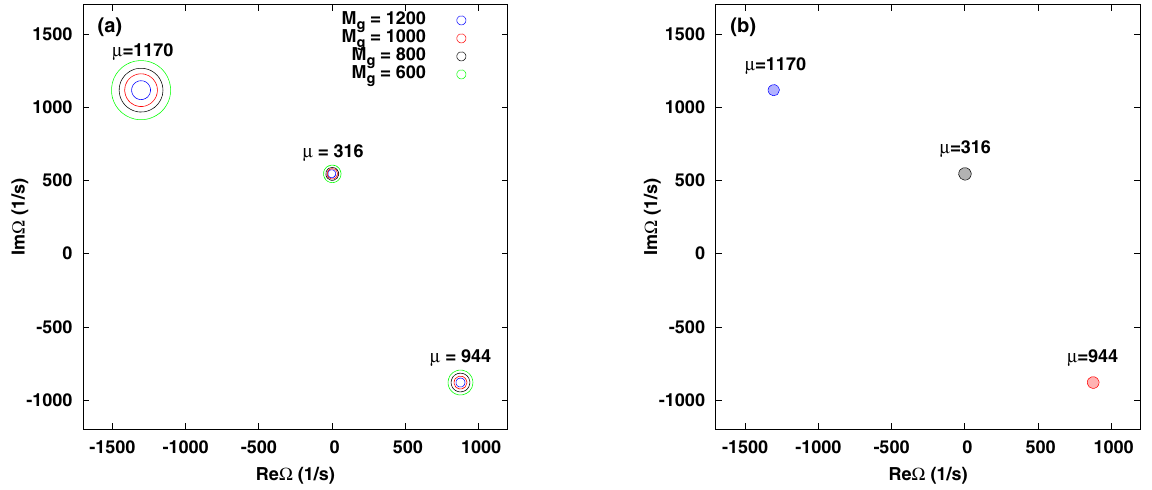
¼ M − g bunches, where g is the gap in the FIG. 7. Gerschgorin circle theorem applied to: (a) a nonuniform filling pattern with M g uniform filling M ¼ 1320 , and (b) the case with fluctuations in the bunch population N on a uniform filling pattern with M ¼ 1320 . m The regions determined by the intersection of the Gerschgorin disks, which, by the continuity of the eigenvalues [39], contain the three eigenvalues with the largest imaginary part, are shown with colored circles for the three fastest growing modes μ ¼ 1170 , 944, 316 of the ¼ 1200 (blue circle), M ¼ 1000 (red circle), M ¼ 800 (gray circle) and M ¼ 800 (green uniform filling case. In (a) the cases with M g g g g circle) are shown. The radius of the Gerschgorin disks goes to zero in the limit of zero gap. In (b) the Gerschgorin disks for the same modes μ ¼ 1170 , 944, 316 are shown with filled circles. Here the bunch population N is generated with a fluctuation of 20%. m